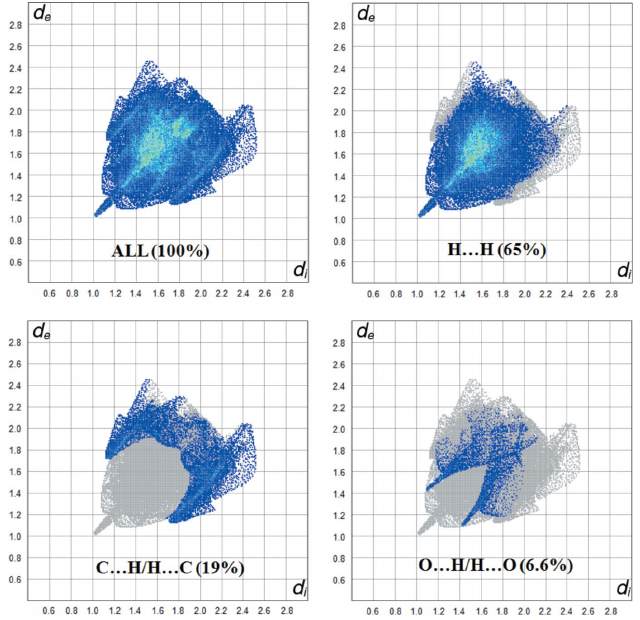
Figure 4 Fingerprint plots showing all intermolecular interactions and resolved into H (cid:2)(cid:2)(cid:2) H, C (cid:2)(cid:2)(cid:2) H/H (cid:2)(cid:2)(cid:2) C and O (cid:2)(cid:2)(cid:2) H/H (cid:2)(cid:2)(cid:2) O contacts.